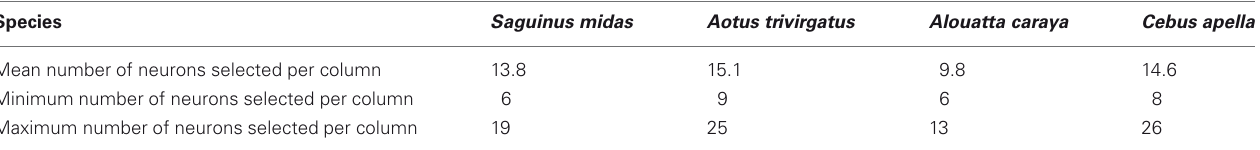
Table 3 | Numbers of layer II and III neurons measured along a sampling axis to estimate soma size.